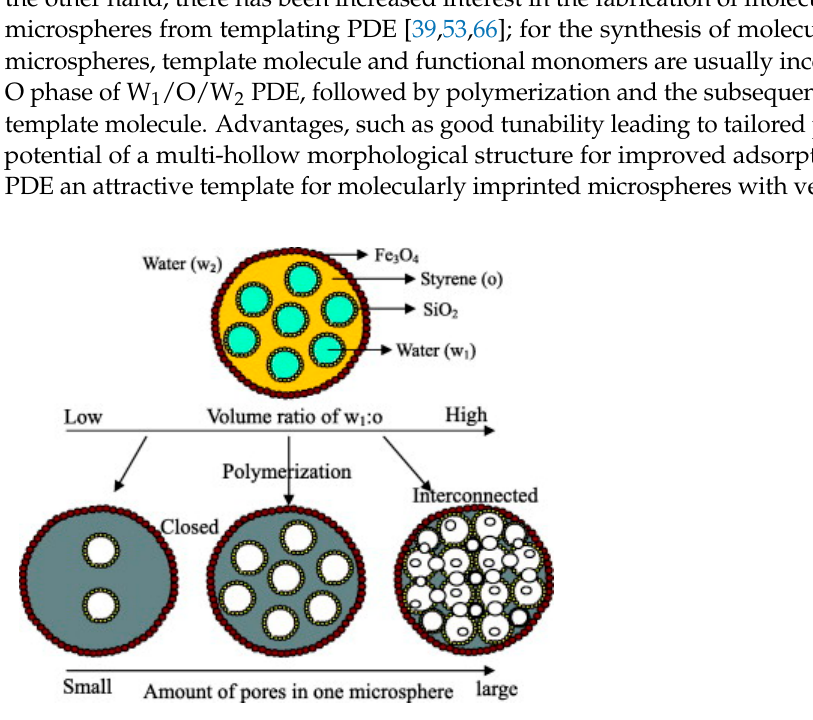
Figure 4. Preparation of multihollow microspheres with tunable pore structures by PDE templating. Reprinted with permission from [32].